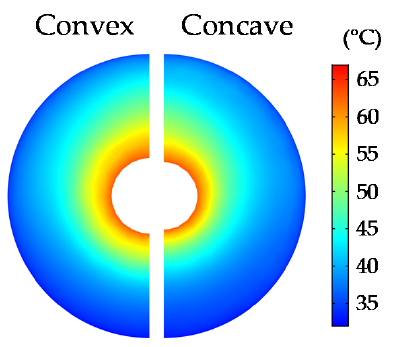
Figure 6. Surface temperature distribution of the spacer.